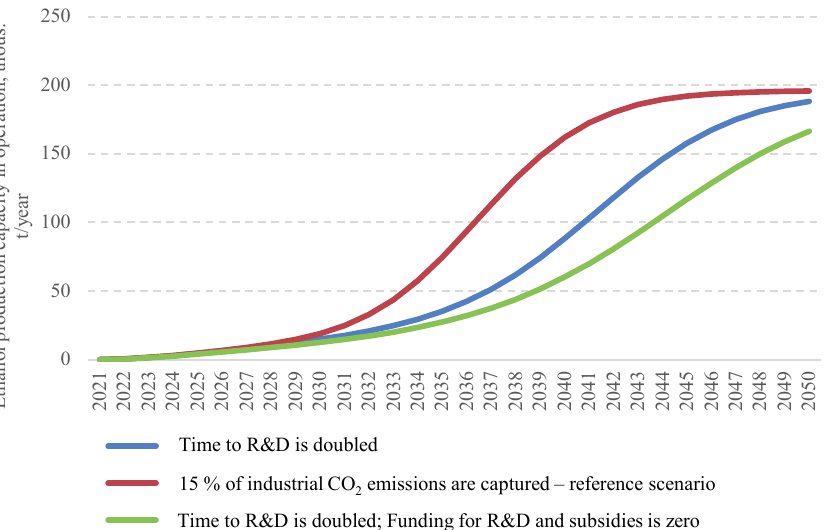
Fig. 6. Comparison of the dynamics of the ethanol production capacity in operation in the reference scenario un and scenarios where 1) the time to R&D is doubled in the model, and in addition, 2) funding for R&D and subsidies is made equal to